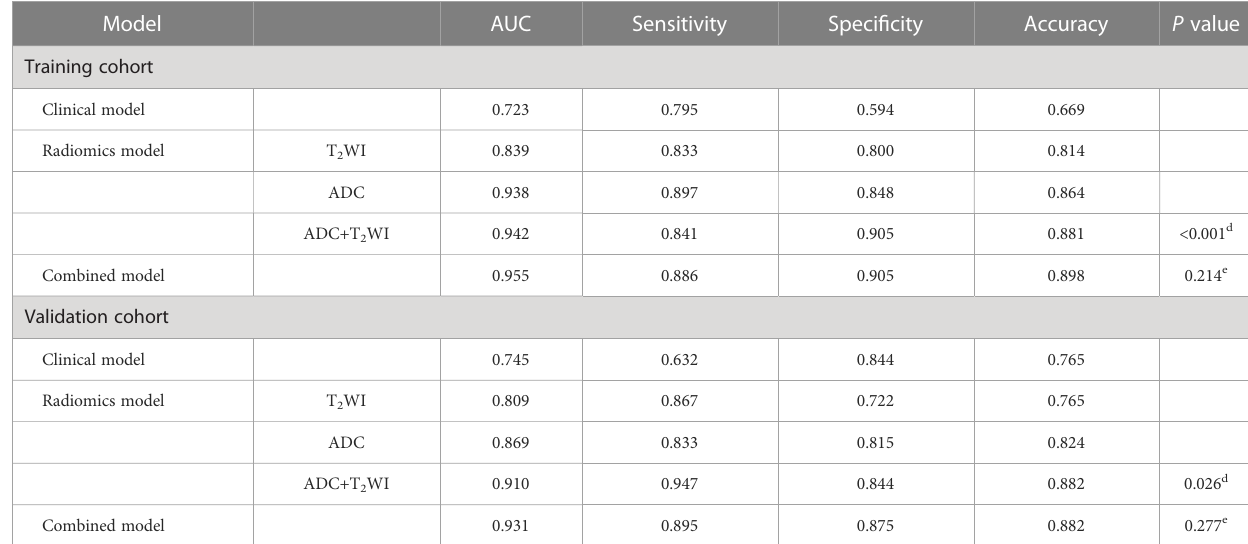
TABLE 3 Performance of clinical and radiomic